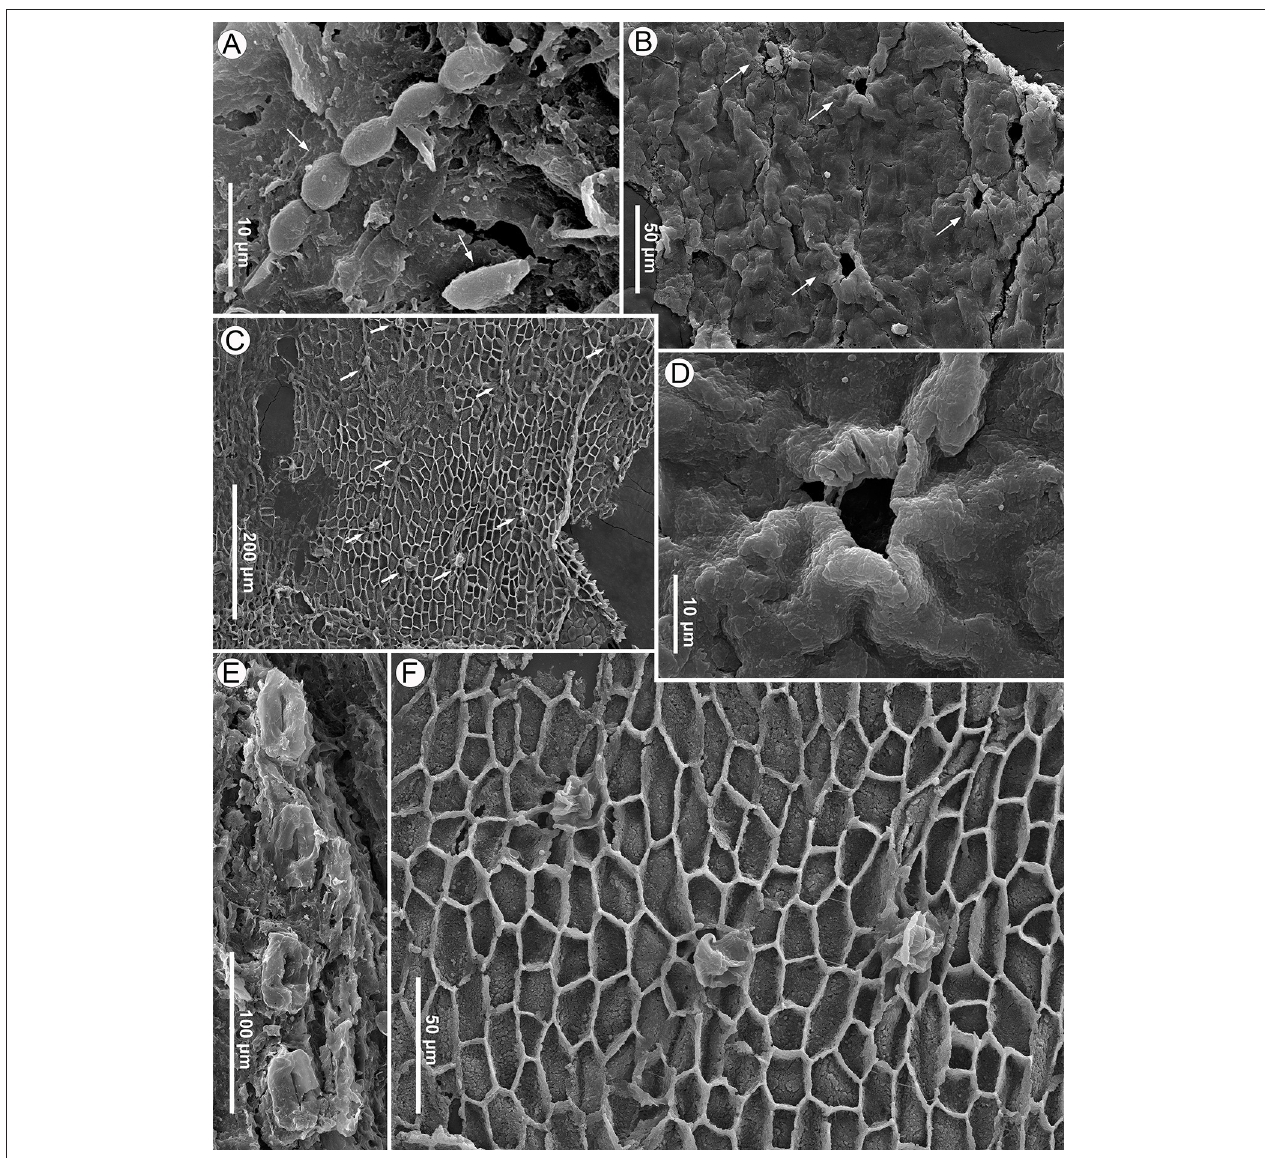
FIGURE 4 | Seed scale cuticle of Pinus prehwangshanensis sp. nov. and fungal remains, specimen MMRH171, SEM. (A) Conidia (arrows) of fungus similar to Cladosporium on seed scale surface. (B) Cuticle of apophysis surface with rare stomata (arrows), outer view. (C) Cuticle of apophysis surface with monocyclic stomata (arrows), inner view. (D) Stoma with papillose subsidiary cells, an enlargement in (B) . (E) A distinct row of stomata on an abaxial surface of a seed scale. (F) Stomata, an enlargement in (C)